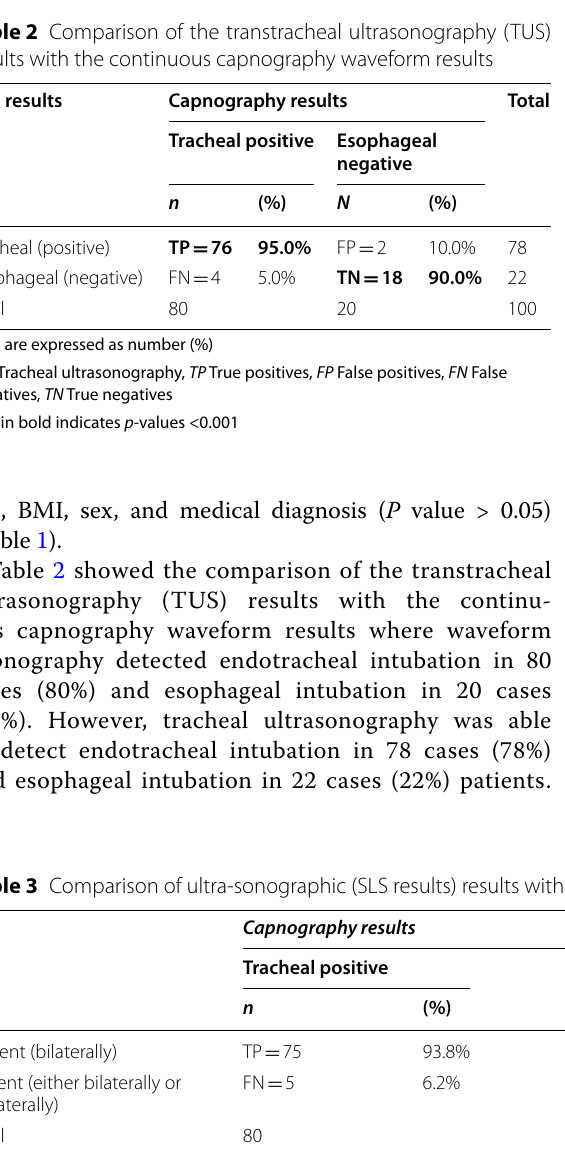
SLS Sliding lung sign, data are presented as number and percentage (%) ( n No. of patients, TP True positives, FP False positives, FN False negatives, TN True negatives) a